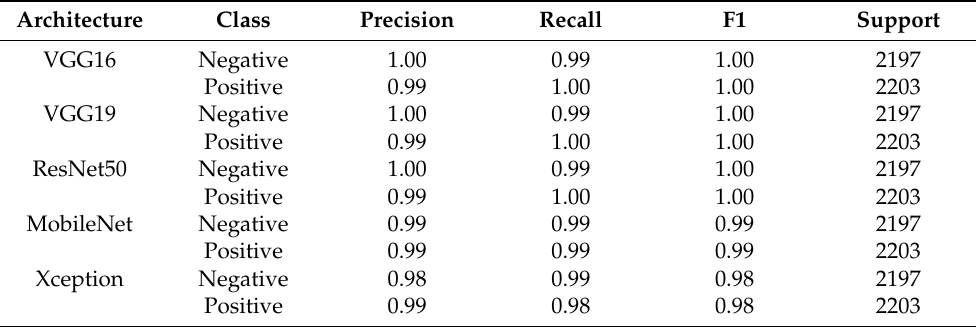
Table 3. Statistical outcomes of the concrete cracks (crack or